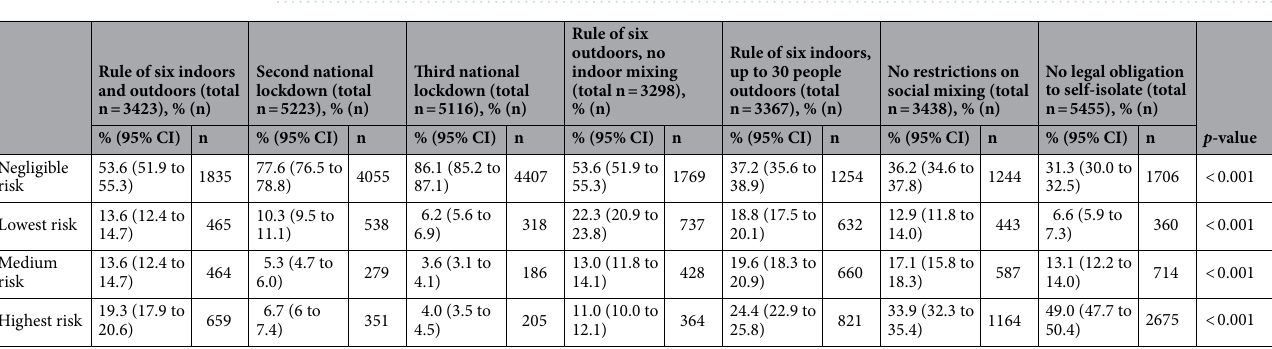
Table 4. Percentage of people engaging in risky social mixing at different time points in the